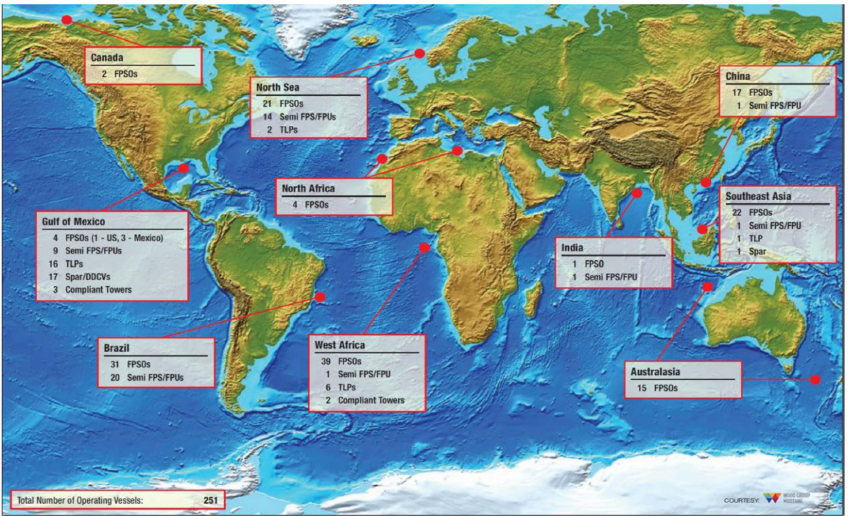
Figure A2. Deepwater Systems Global Distribution showing different offshore platforms and the total number of operating vessels (Courtesy: Wood Group